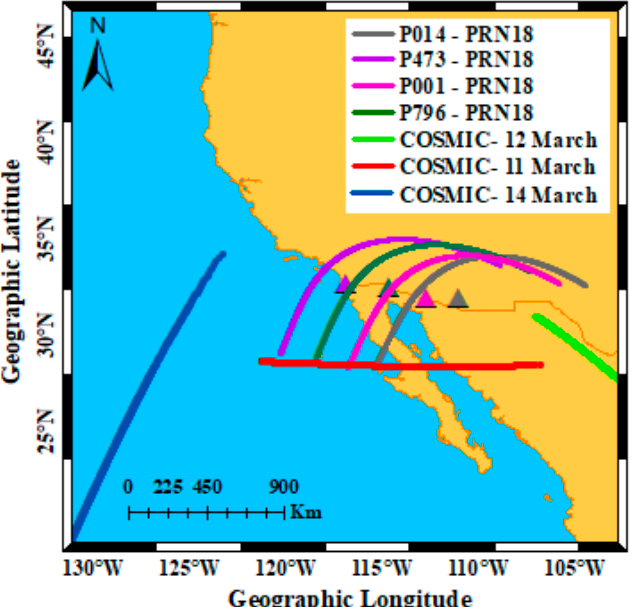
Figure 17. IPP tracks of GPS PRN 18 from the four southward stations and tangent point projections of F3/C RO observations.